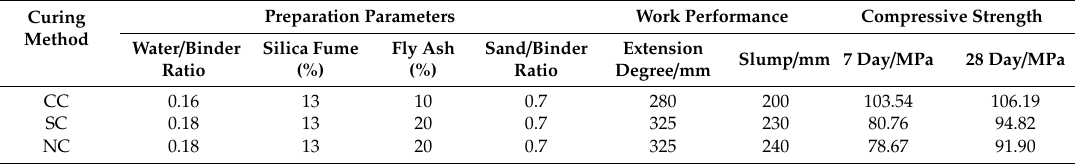
Table 11. Mechanical properties of the optimum mixing ratio for range